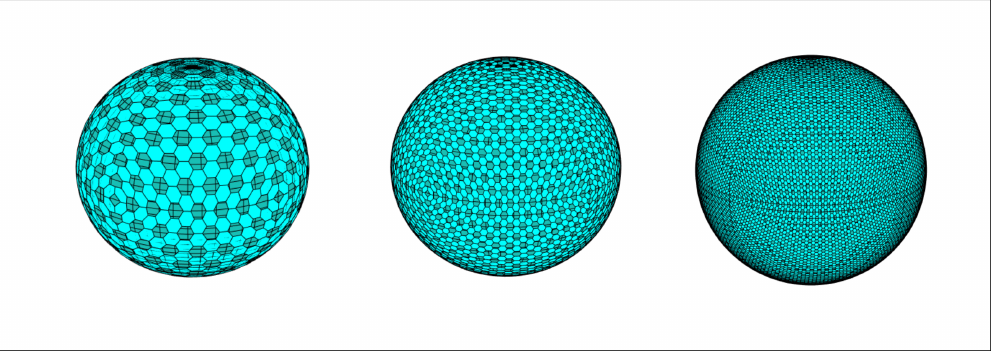
Figure 16. Four-fold Class I Hexagon DGGSs based on the octahedron version of SACs (level = 4, 5, 6).